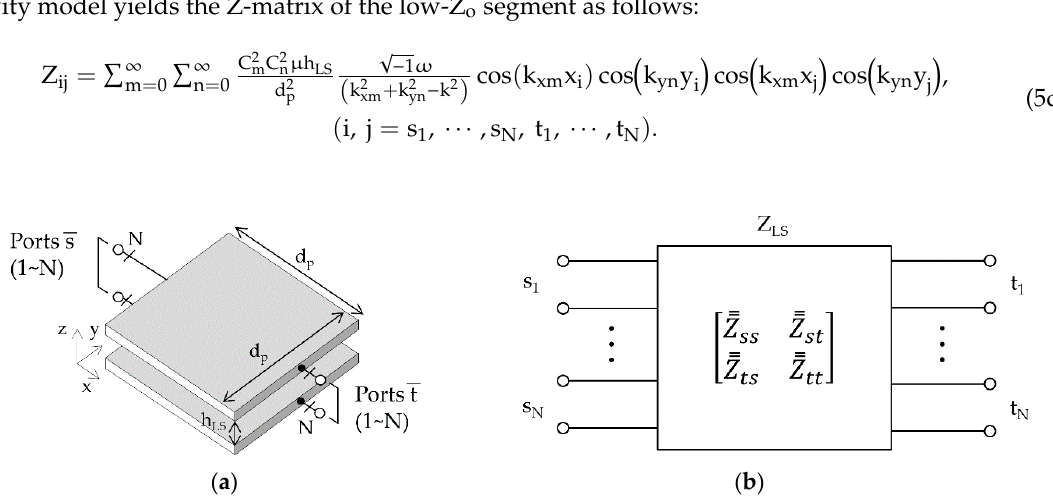
Figure 7. ( a ) Ports and design parameters; ( b ) the Z-matrix (Z HS ) of the high-Z o segment.